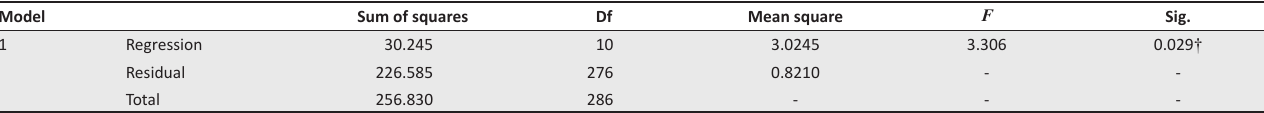
TABLE 4b: Regression results of demographic characteristics and peripheral neuropathy domains. (b) Overall significance. Model